Question: Express in one sentence what the figure is showing.
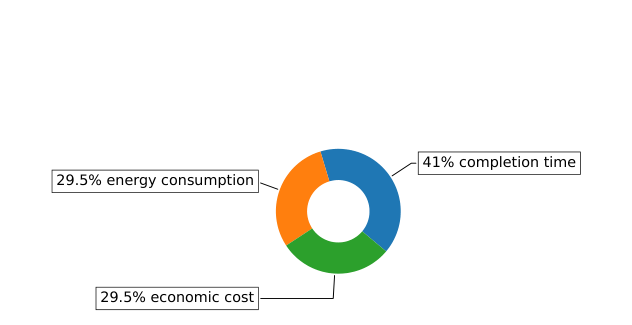
Answer: Percentages of research articles addressing the time, energy, or cost objectives.